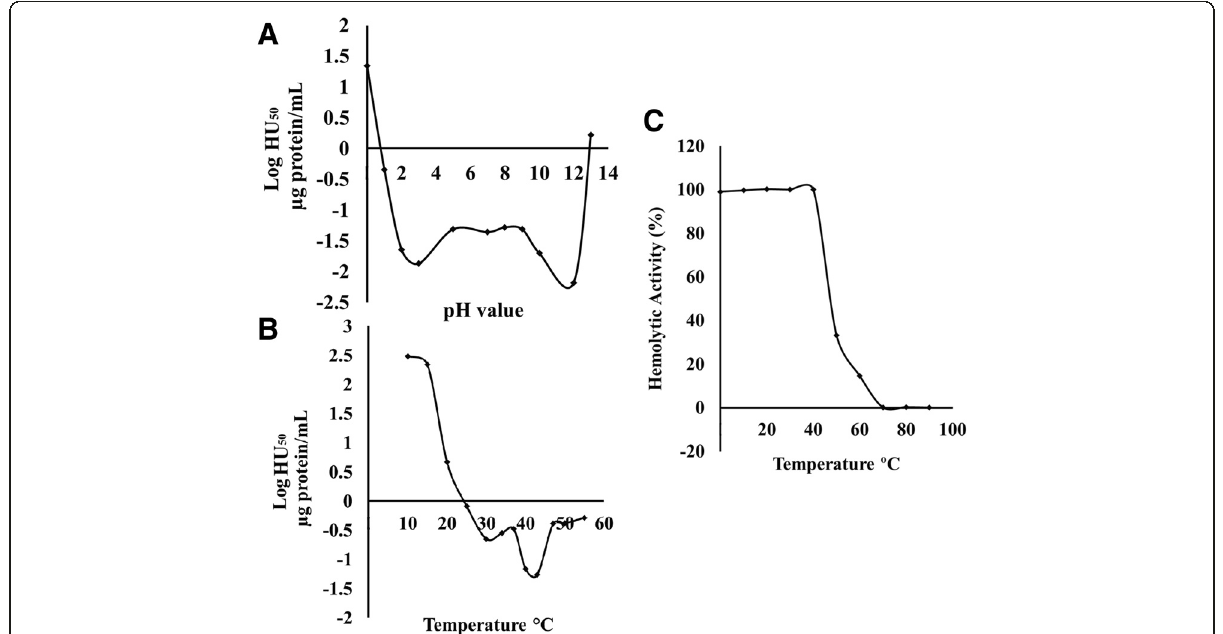
Fig. 2 Effect of ( a ) pH and ( b ) incubation temperature on the hemolytic activity of the aqueous extract of M. alcicornis . c Stability of the hemolytic activity of the extract after its incubation at different temperatures